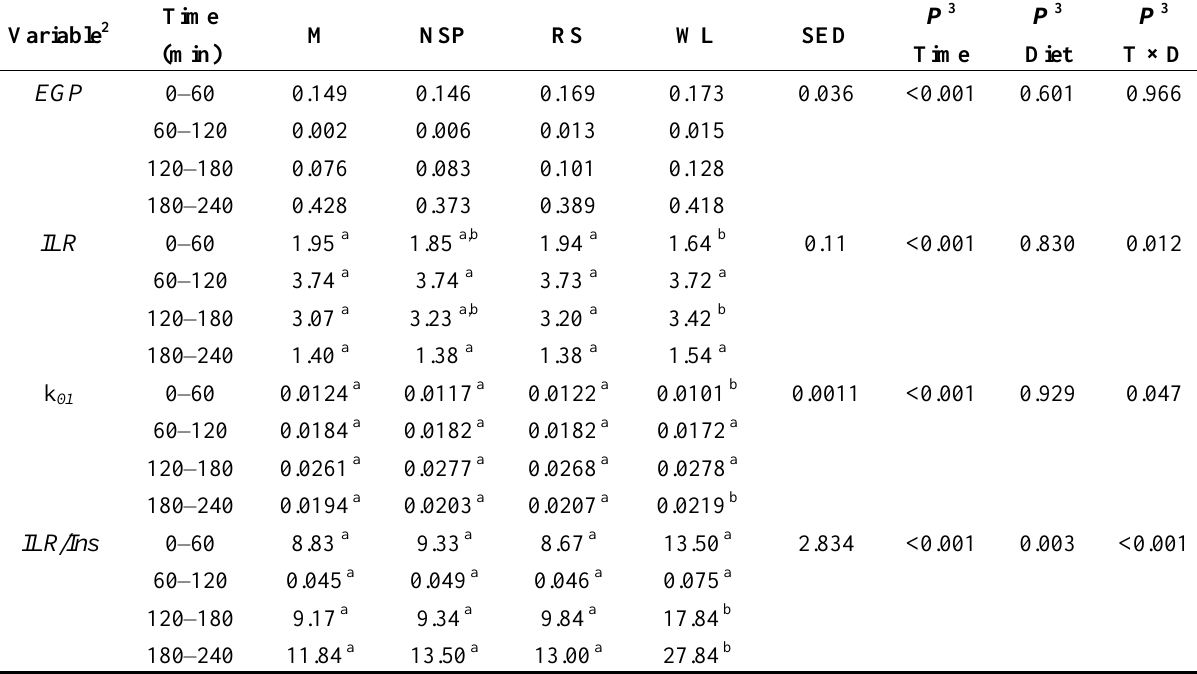
Table 4. Kinetic parameters showing effect of diet on glucose dynamics and insulin sensitivity, as assessed by the Simple model, for 60 min intervals for the 2 h during and 2 h after dextrose infusion in 14 volunteers after an overnight fast following the dietary interventions 1